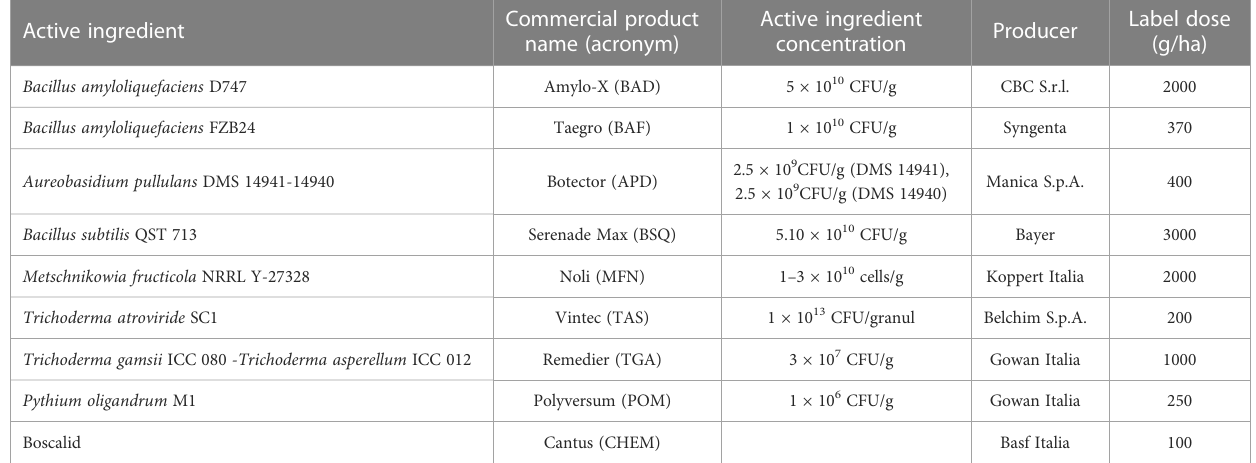
TABLE 1 Plant protection products used in the